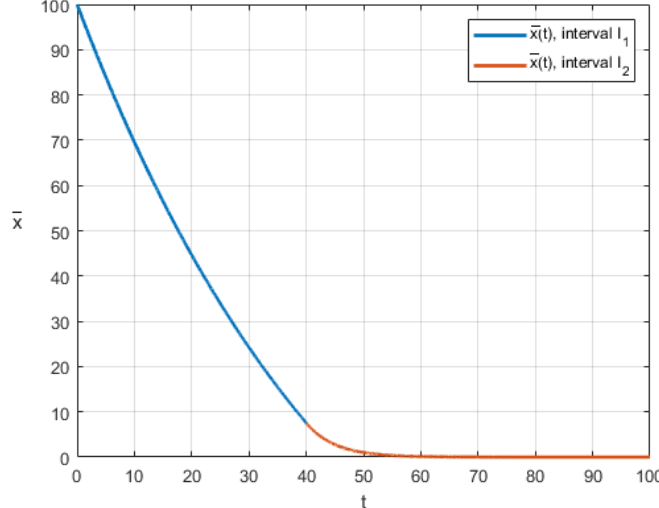
Figure 3. Optimal cooperative trajectory in the case of time-dependent